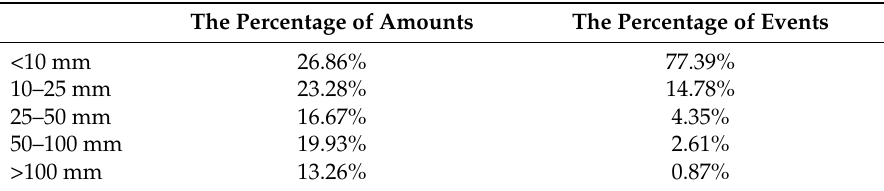
Table 2. The distribution of rainfall during our study